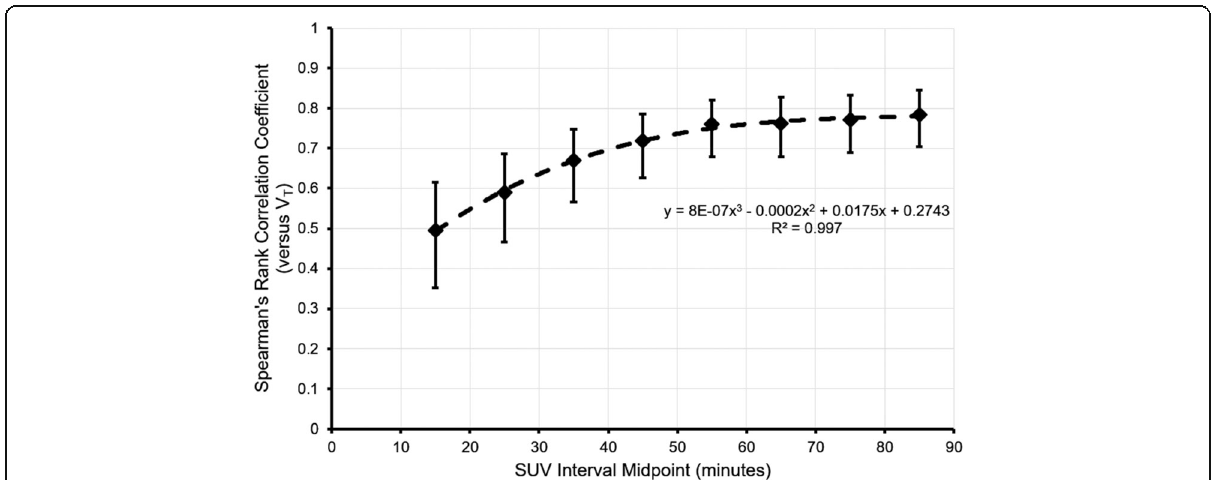
Fig. 1 Spearman ’ s rank correlation coefficient versus the midpoint of the SUV interval. The correlation coefficient refers to SUV versus original ppIF-derived V T for seven ROIs pooled. Error bars indicate 95% confidence